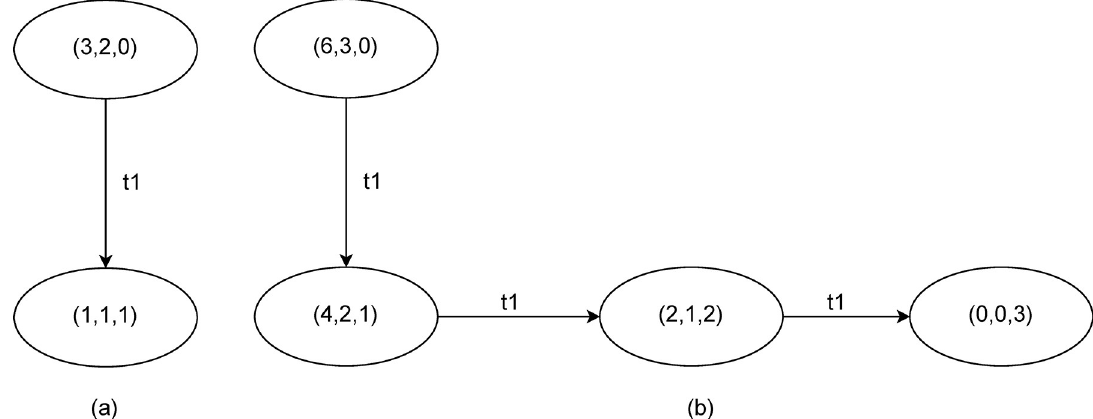
Fig 2. Two reachability graphs for the blade production model. (a) Reachability graph for the blade production model with an initial marking with two tools and one core available. (b) Reachability graph for the blade production model with six tools and three cores available. Ovals represent states with the corresponding marking written inside. Directed arrows represent edges and correspond to an occurrence of transition t1.